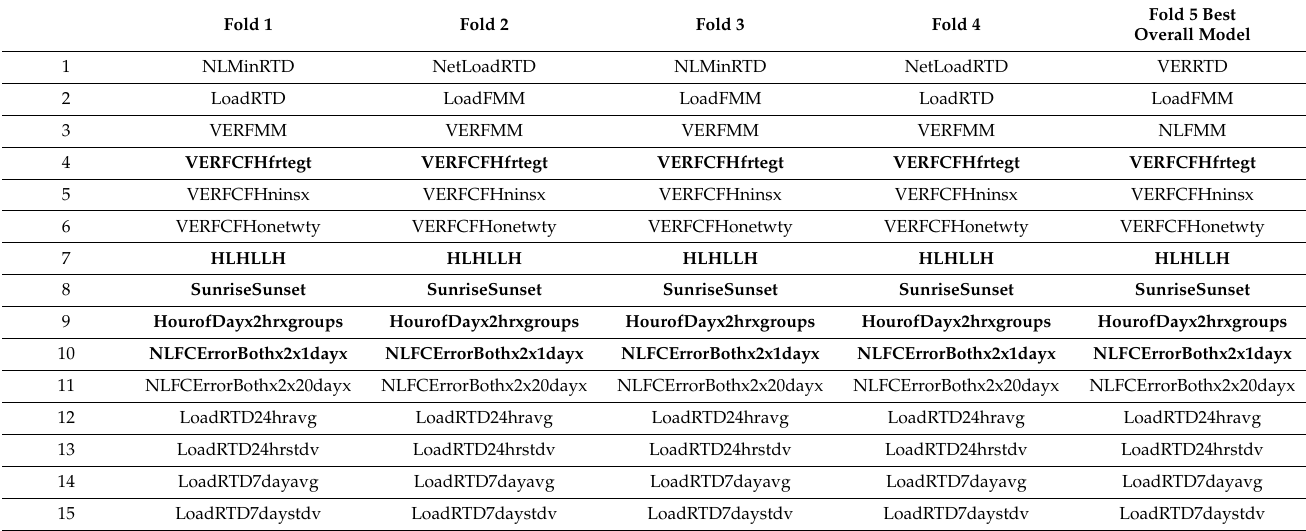
Table 6. RA best model Independent